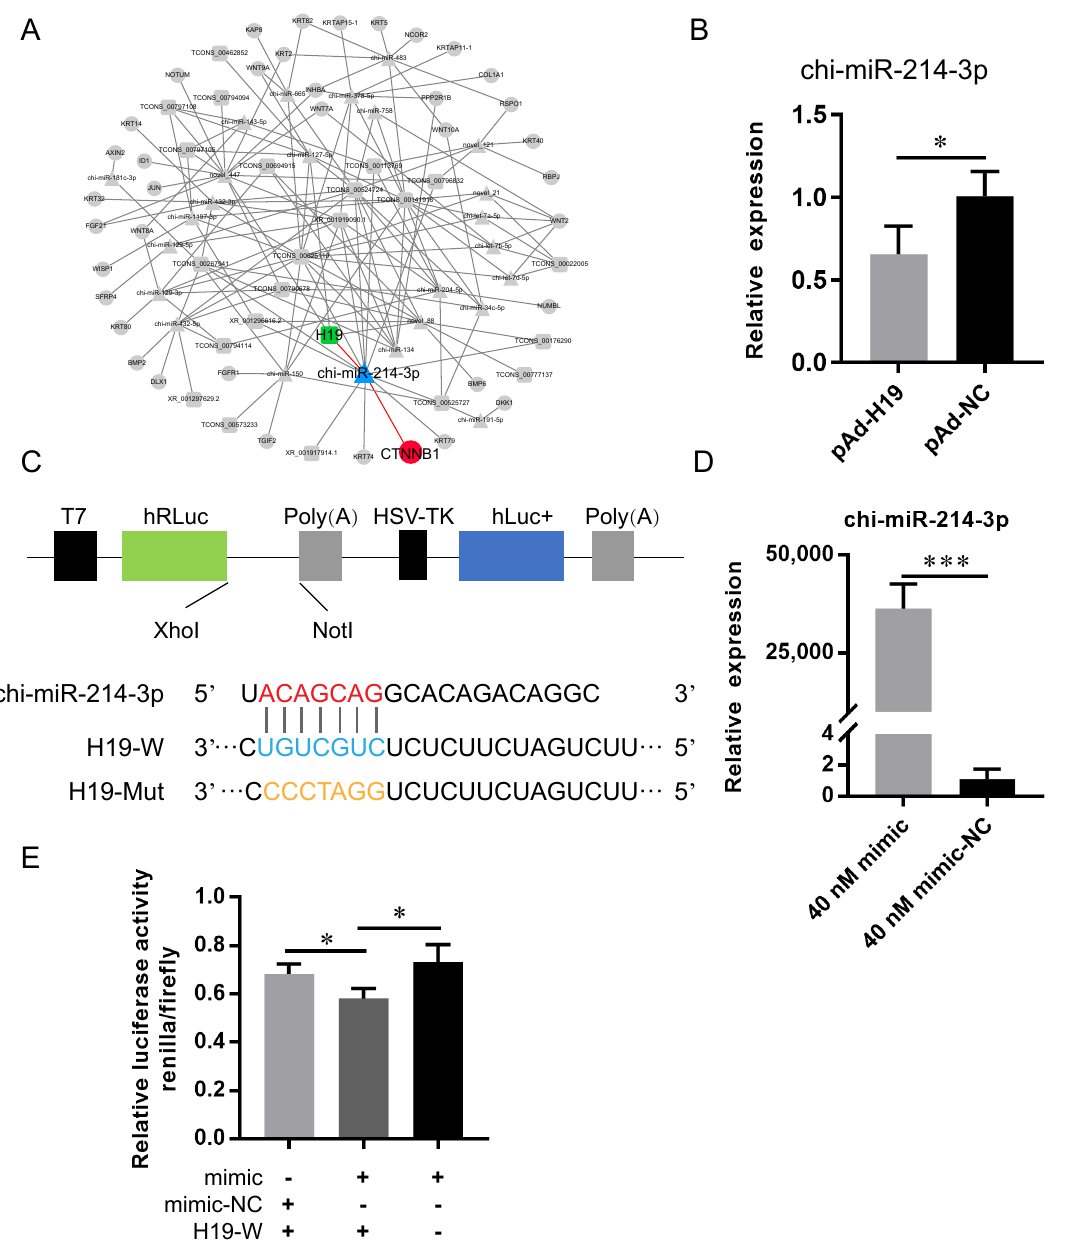
cell cycle-mediated factors, c-myc and cyclinD1, were improved (Figure 5F). These findings revealed that β -catenin promoted the cell cycle of DP cells.